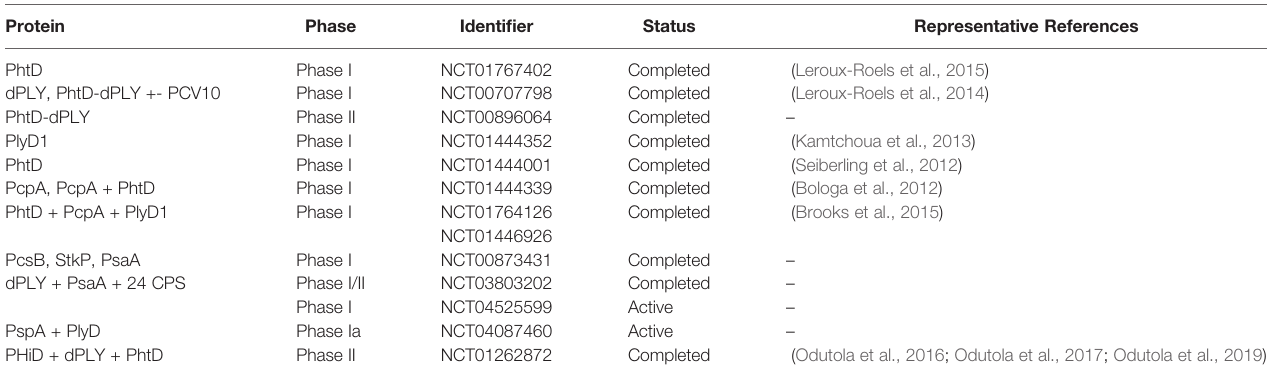
TABLE 2 | Representative candidate protein-based vaccine formulations and trials.